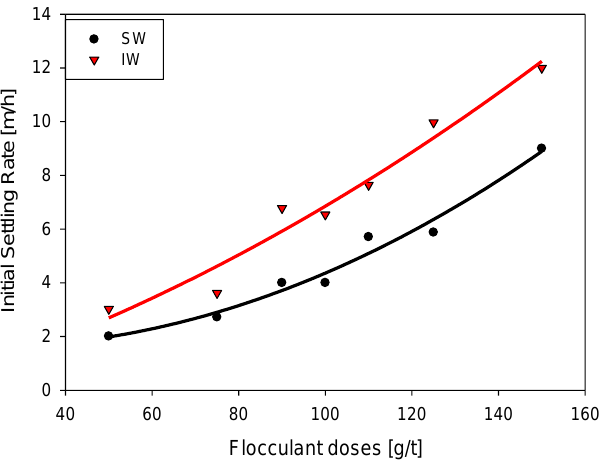
Figure 5. Effect of flocculant dosage on the initial sedimentation rate of kaolin in SW and IW. Stirring rate 180 rpm, solids concentration 5 wt%, flocculation time 15 s, and pH 7.